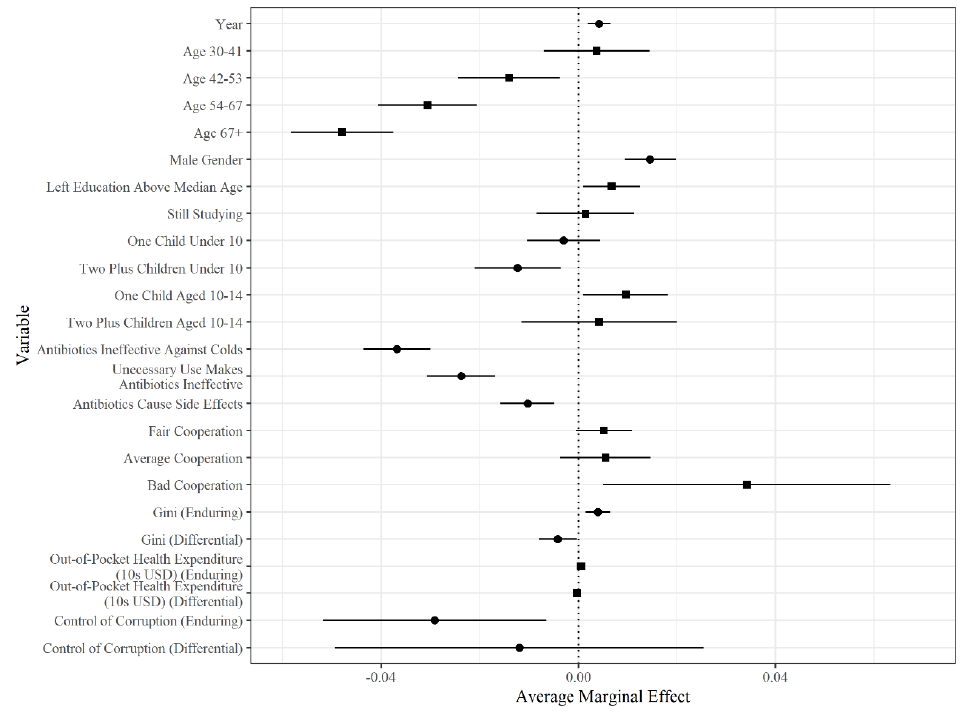
Figure 2: Average marginal effects of significant variables in the mixed-effects regression model, with 95% confidence